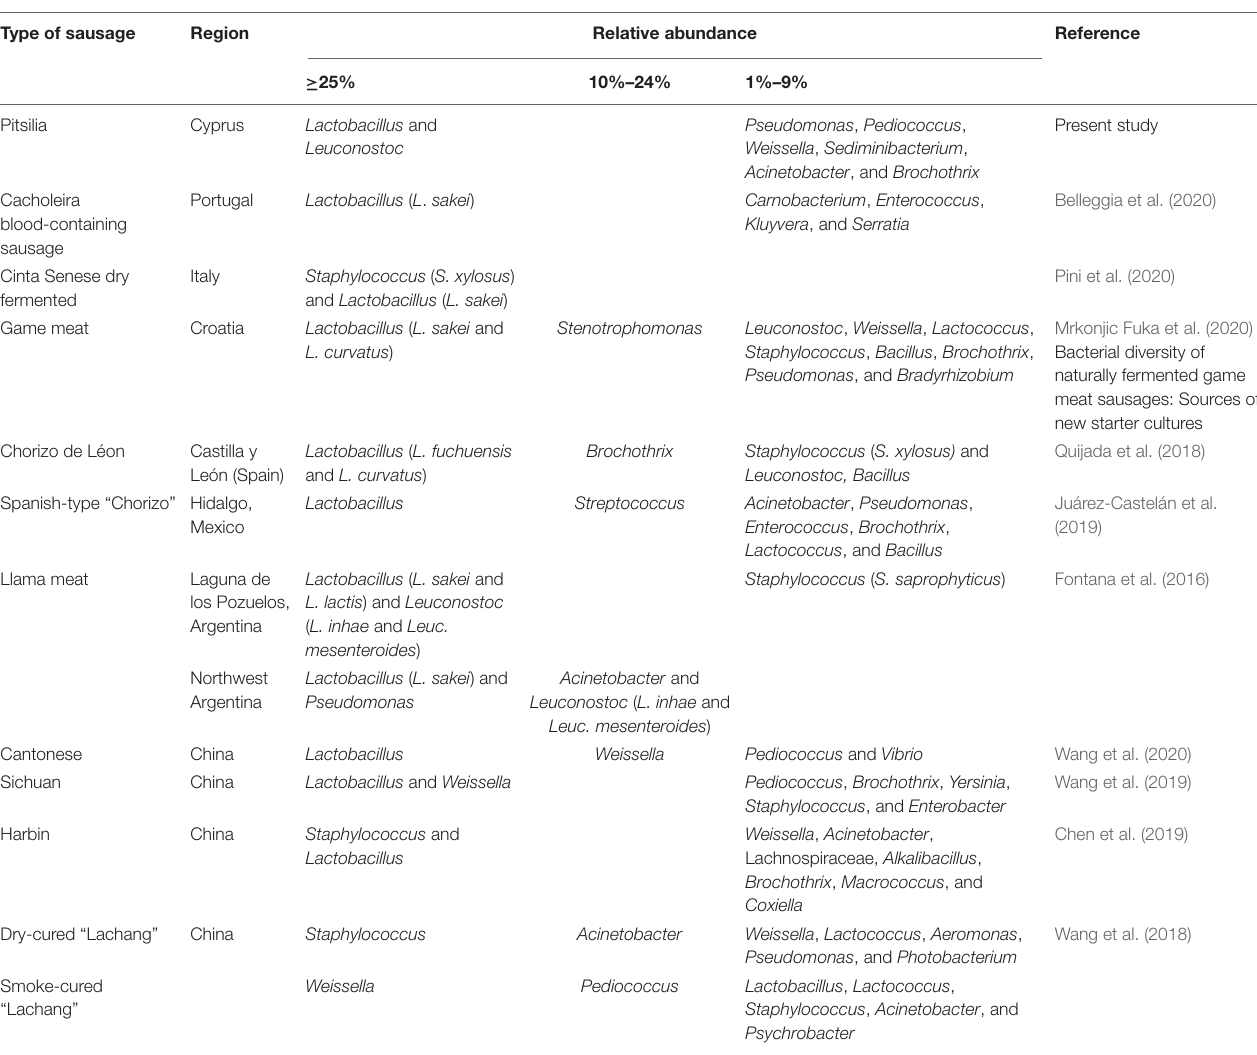
TABLE 3 | Relative abundances of bacterial genera (and some species) that were detected in sausages via 16S rDNA